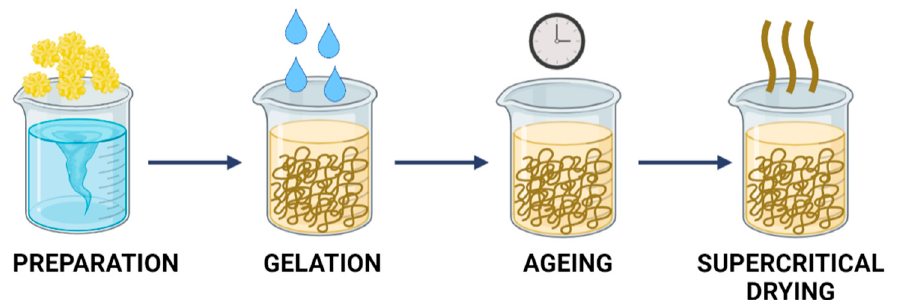
Figure 6. Formation of porous materials by the sol-gel